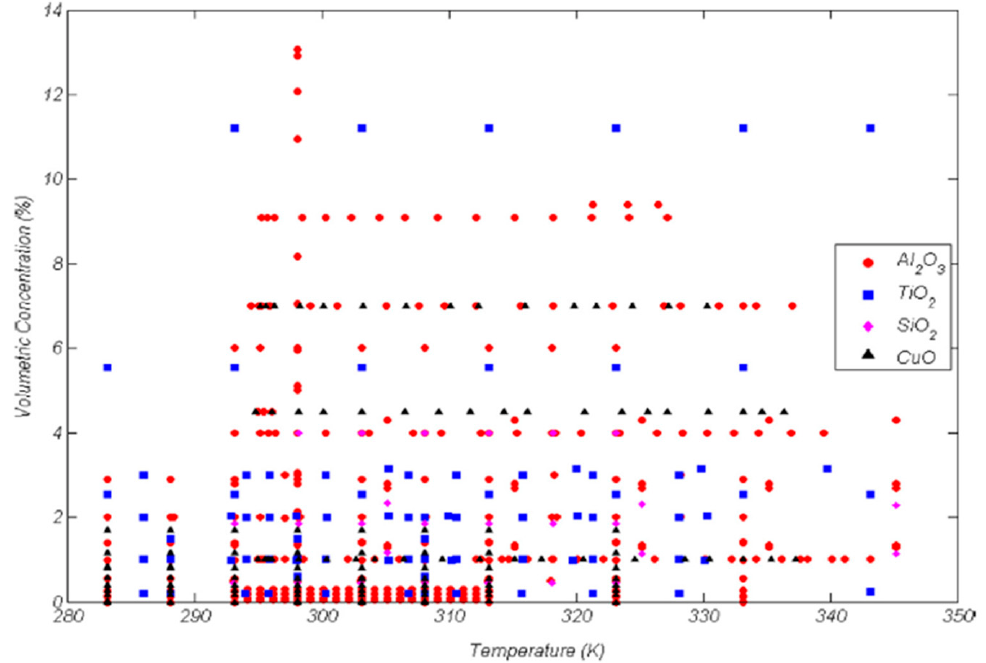
Figure 14. Divergence of viscosity data of different nanofluids under varying temperature and volumetric concentration [174].